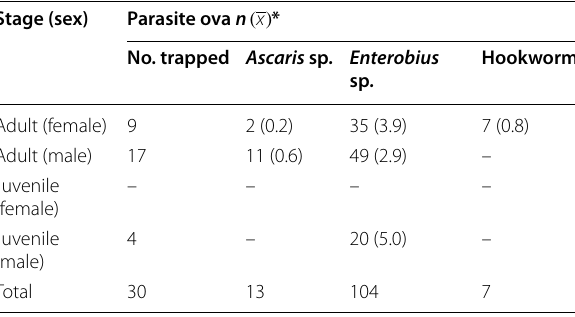
Table 2 Parasite ova detected in Agama lizards trapped